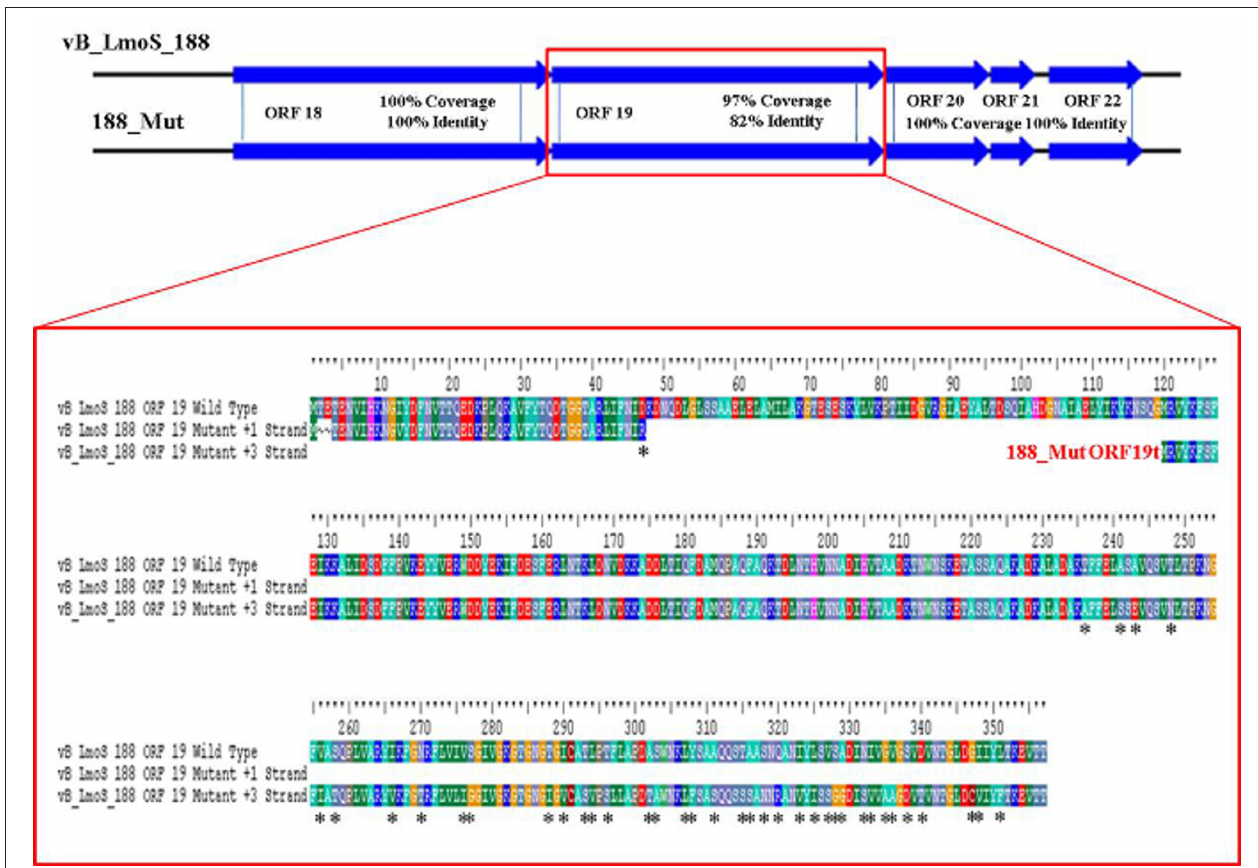
FIGURE 8 | Amino acid sequence alignment of open reading frame (ORF) 19 in phage vB_LmoS_188 and its corresponding ORF in phage 188_Mut. Alterations in amino acid sequence in the mutant ORF compared to the wild-type are denoted with